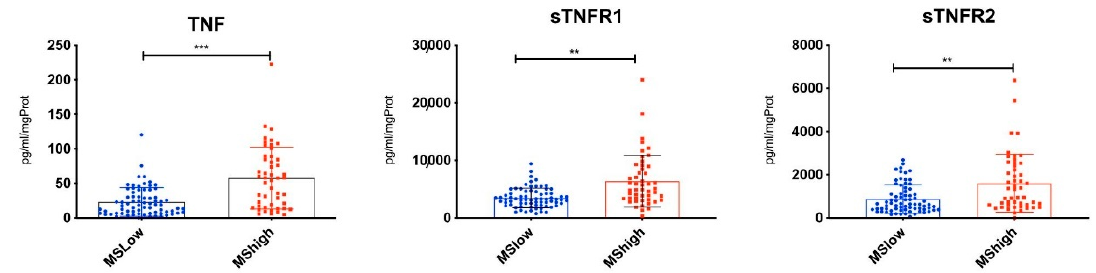
Figure 4. CSF levels of TNF and sTNFRs in MS patients stratified according to the high (MS-High) or low (MS-Low) cortical lesion load. Significant increased levels of TNF (*** p < 0.001), sTNFR1 (** p < 0.01) and sTNFR2 (** p < 0.01) were detected in CSF of MS-High compared to MS-Low patients at time of diagnosis.